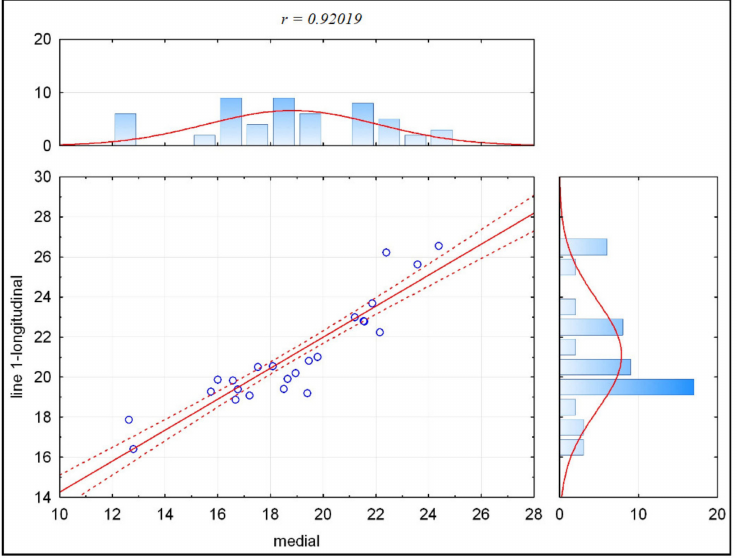
Figure 7. Correlation between the pairs of parameters (medial and line-1 longitudinal) in male